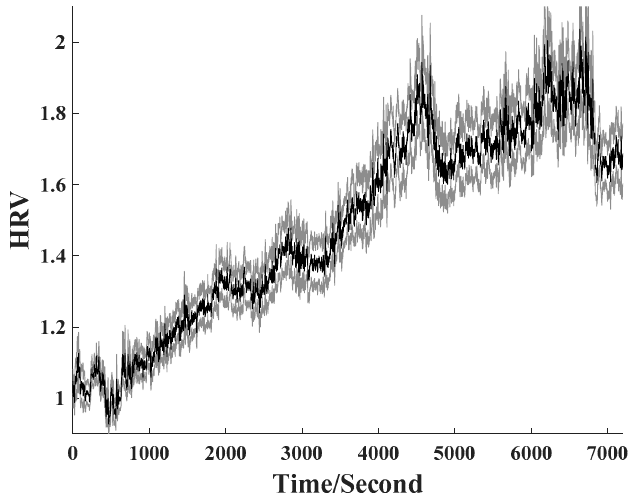
Figure 3. HRV changing trend along with the accumulation of mental arithmetic time. The shaded error bar represents the standard error of the mean HRV across 20 subjects.